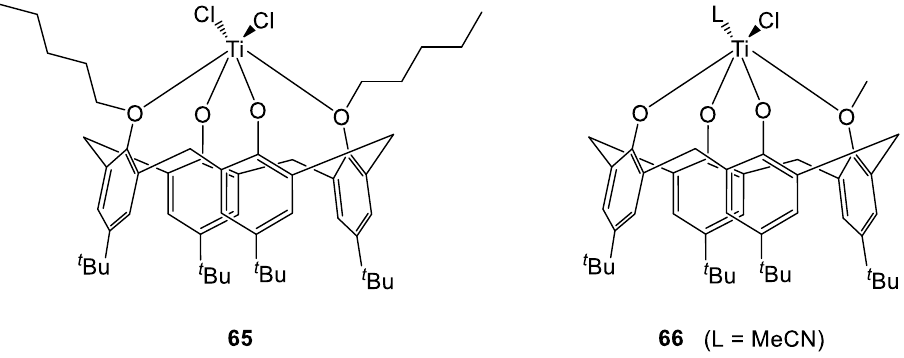
Figure 17. Titanium calix[4]arene complexes 65 and 66 (isolated as MeCN solvates) [29].